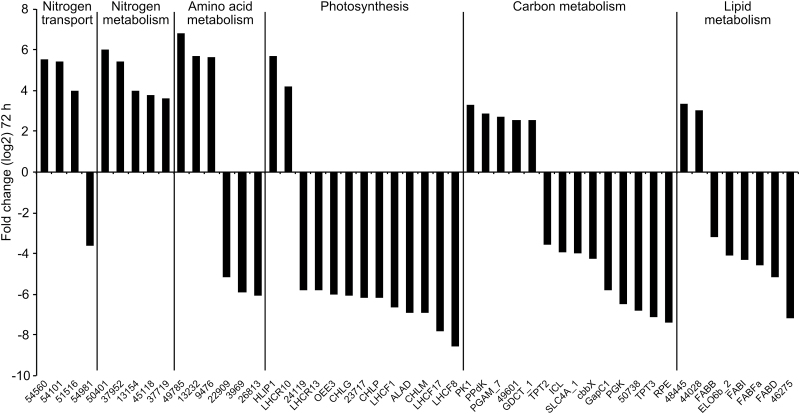
Genes strongly regulated by N deprivation. The genes most up- or downregulated after 72h of nitrate deprivation are shown for the processes listed at the top of the graph. The ratios were log2 transformed. Numbers indicate Phatr2 gene IDs.